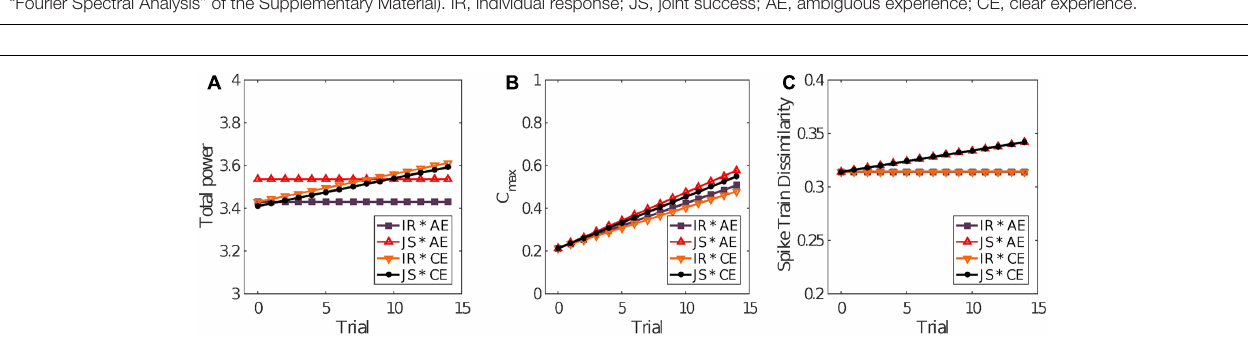
D a , bOriginal ( M = 0.215, SD = 0.020) was not significantly different than the average for the surrogate pairs D a , bSurrogate ( M = 0.215, SD = 0.009), t (16) = − 0.010, p = 0.992. The D a , bOriginal ( M = − 0.170, SD = 0.015), when compared t (16) = − 0.782, p =